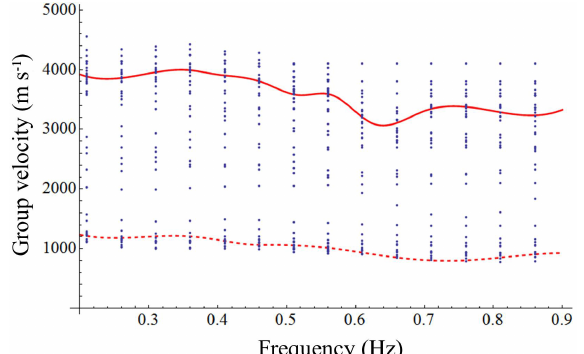
Figure 12. A set of dispersion curves estimated from all EGFs of DAFNE array (blue dots) that demonstrates their bimodal distribu- tion. Averaged dispersion curves calculated for two groups of seis- mic station pairs (see explanation for Group 1 and Group 2 in the text) are shown by dashed line (Group 1) and solid line (Group